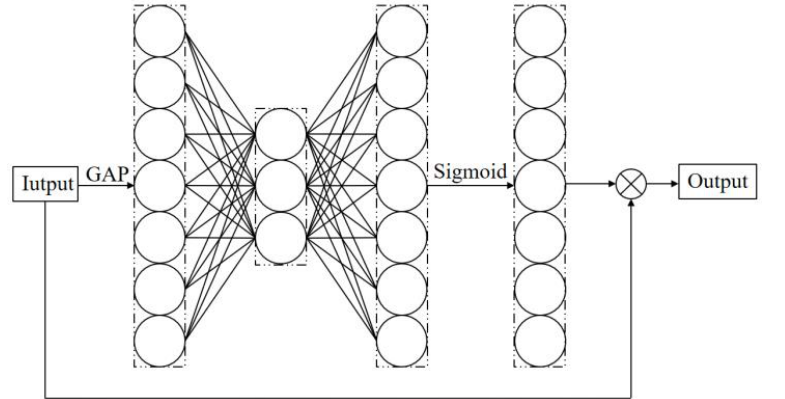
Figure 9. Structure of CBAM module.